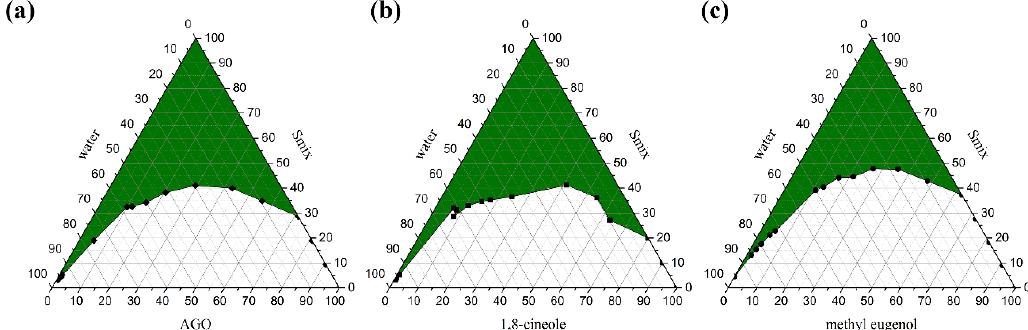
Figure 1. Pseudo ternary phase diagrams of Alpinia galanga oil (AGO) ( a ), 1,8-cineole (C) ( b ), and methyl eugenol (M) ( c ) using Tween 80 and absolute ethanol at a weight ratio of 2:1. The green area represents the monophasic area. Table 1. Composition of microemulsion (ME) formulations (% w / w